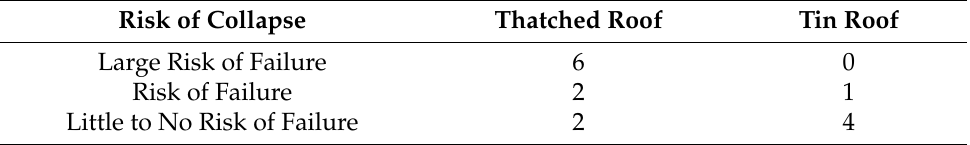
Table 2. Ground-truthing of 15 buildings, comparing roof type to risk of building